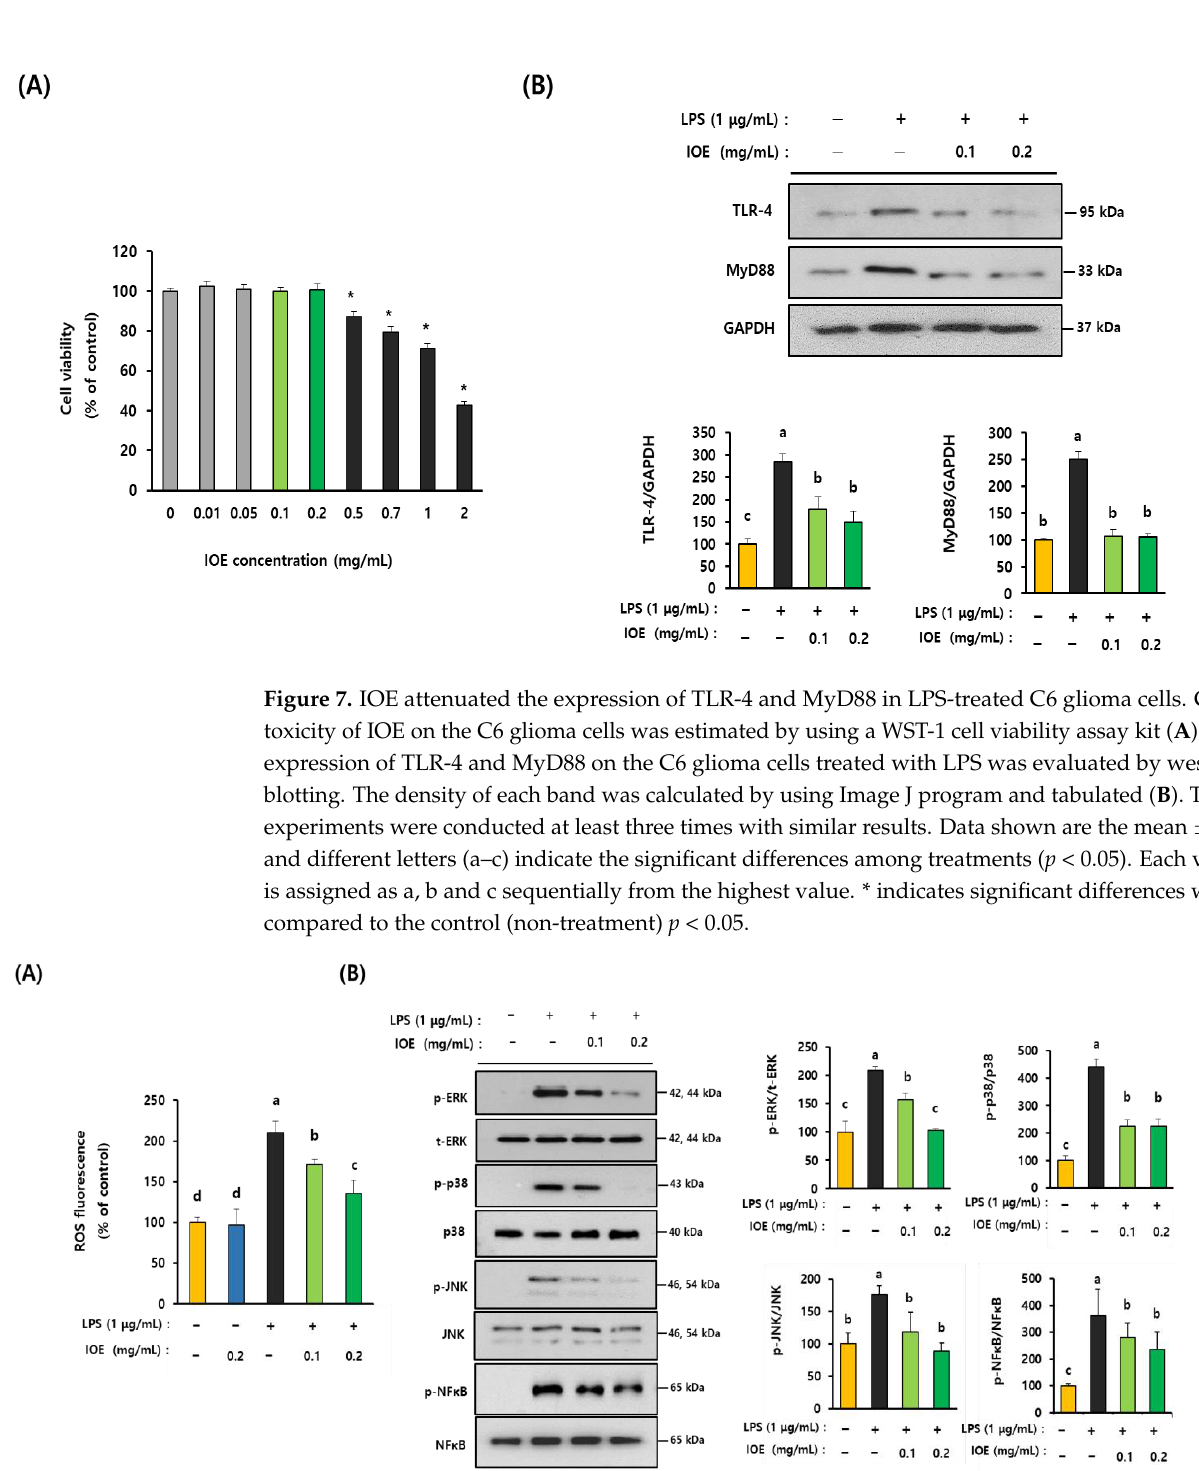
Figure 8. LPS-induced dysregulation of ROS, MAPKs and NF κ B on C6 glioma cells were restored by pretreatment of IOE. C6 glioma cells were pretreated with IOE (0.1 and 0.2 mg/mL) and then stimulated with LPS (1 µg/mL). ROS production was evaluated by using a microplate fluorometer ( A ). The expression of each protein was estimated by western blotting. The density of each band was calculated by using Image J program and the ration of phosphorylated MAPKs/total MAPKs and phosphorylated NF κ B/total NF κ B was calculated and tabulated ( B ). These experiments were repeated three times with similar results. Data shown are the mean ± SD and different letters (a–c) indicate the significant differences among treatments ( p < 0.05). Each value is assigned as a, b and c sequentially from the highest